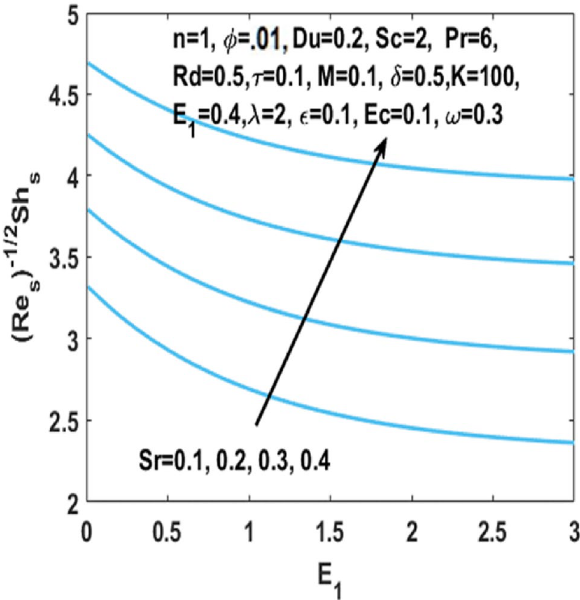
Figure 16. Impact of Sr on Sherwood number w.r.t E 1 .